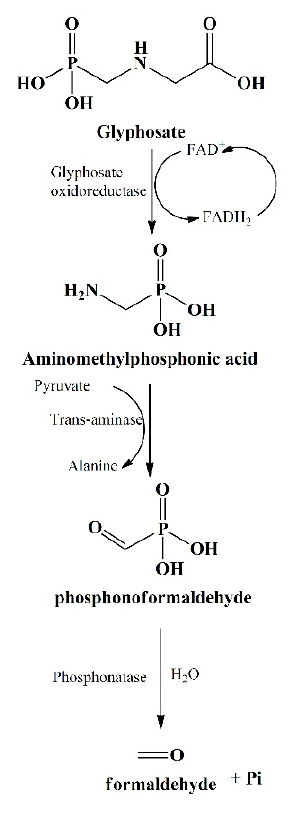
Figure 3. Glyphosate bio-degradation pathway via Aminomethylphosphonic acid (AMPA) and formaldehyde formation.